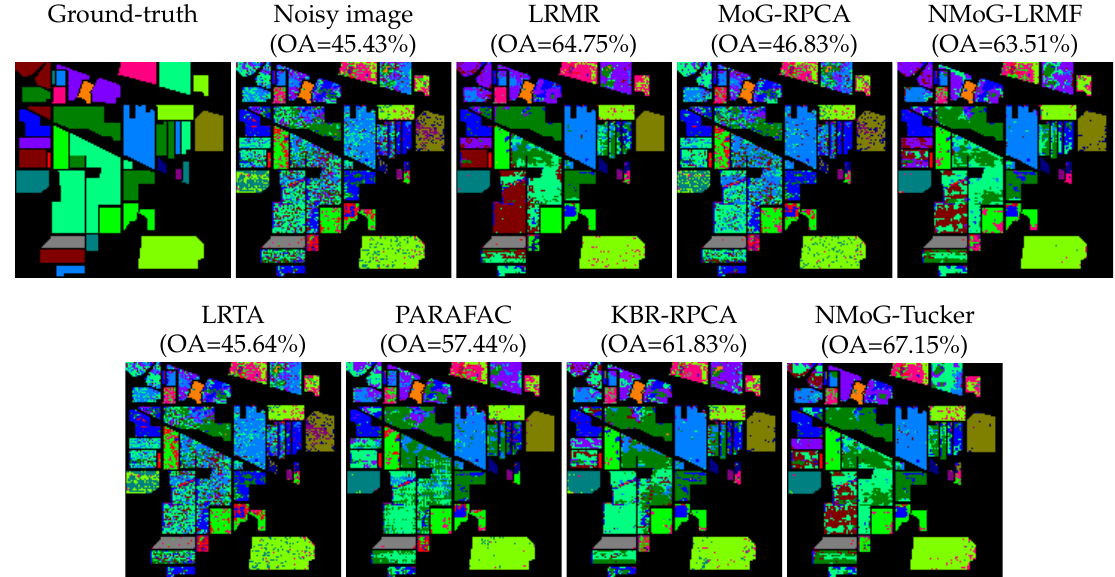
Figure 7. Real HSI classification example on Indian Pines . The classification results are obtained by performing SVM on the noisy and the denoised HSIs, and the corresponding OA values are reported in